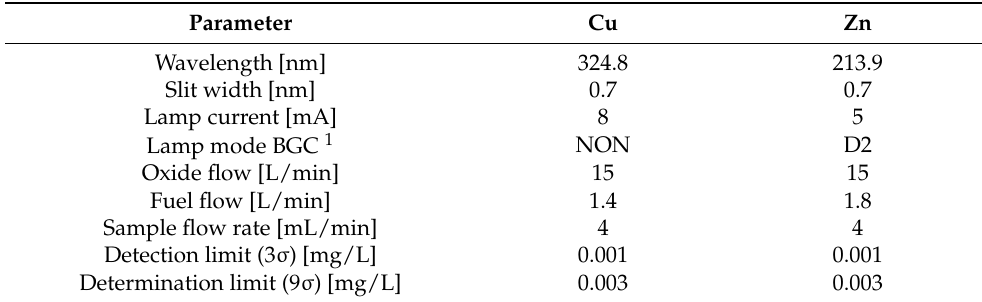
Table 1. Measurement conditions for analytical technique (F-AAS) used for determinations of Cu and Zn. Parameter Cu Zn Wavelength